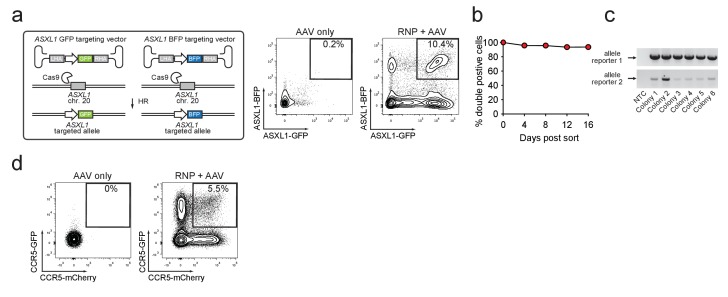
Identification and enrichment of biallelic genome-edited CD34+ human hematopoietic stem and progenitor cells (HSPCs).(a) Left, Schematic showing biallelic targeting strategy for ASXL1 using GFP and BFP-encoding rAAV6 donors for integration into each allele of ASXL1. The SFFV promoter drives reporter expression. Middle, FACS plot from an ‘AAV only’ sample day four post electroporation, showing low episomal reporter expression (BFP and GFP) in cells without the CRISPR system. Right, FACS plot of CD34+ HSPCs treated with both Cas9 RNP and the two rAAV6 donors highlighting the generation of BFPhigh/GFPhigh double positive cells that have undergone ASXL1 dual-allelic targeting. (b) HSPCs were targeted at both alleles of HBB (Cas9 RNP with GFP and tdTomato rAAV6 donors) and at day four post electroporation, dual positive cells were sorted and cultured for 16 days while analyzing reporter expression. Error bars representing S.E.M. are present, but too small to be visible (N = 3 different HSPC donors). (c) Gel images showing PCR genotyping of six methylcellulose-derived clones from (e) confirming integration into each of the HBB alleles. (d) Human primary T cells were CD3/CD28 stimulated for three days and then electroporated with CCR5-targeting Cas9 RNP and transduced with two CCR5-specific rAAV6 donors encoding GFP and mCherry, respectively. FACS plots show GFPhigh/mCherryhigh biallelic targeting frequencies at day four post-electroporation.